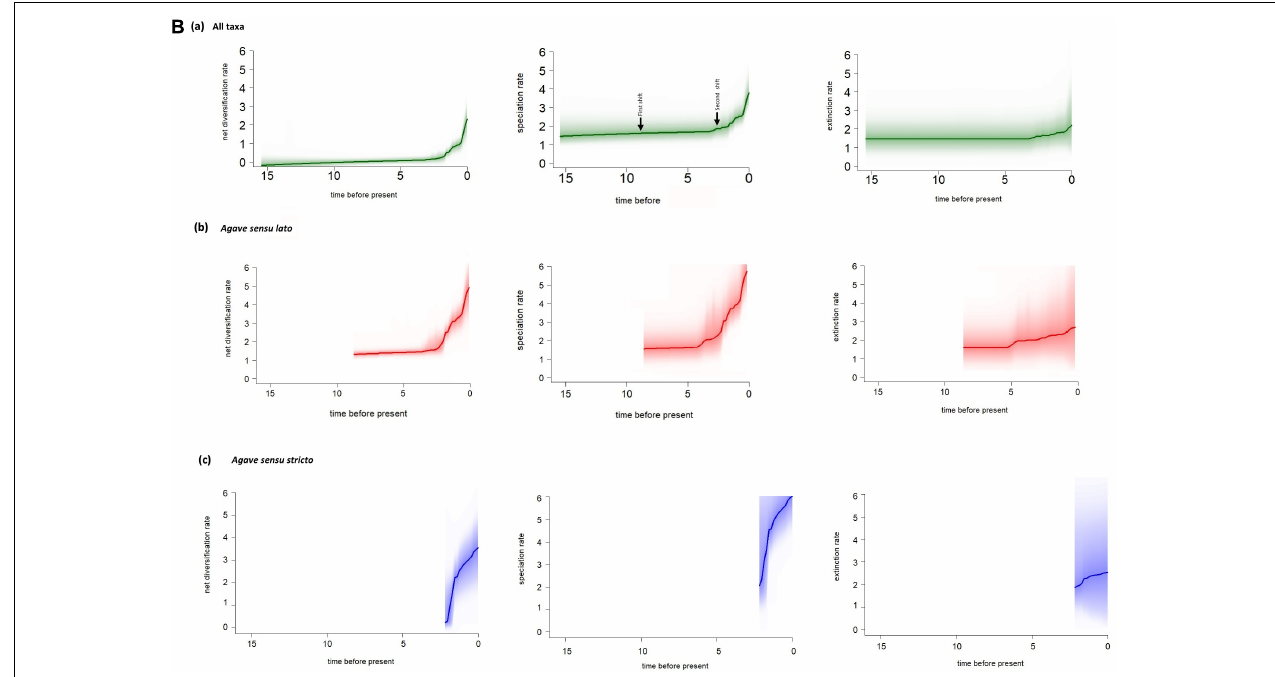
FIGURE 4 | BAMM analysis of rate shift configurations and diversification within Agave sensu lato . (A) Rate shift configurations with the two highest posterior probabilities from the 95% credible set are indicated with red circles, and branches are colored according to median net diversification rates (cool colors = slow, warm = fast). The first shift corresponds to the stem of A. bracteosa branch and the sister group Agave sensu lato clade, and the second shift corresponds to the Agave sensu stricto clade. Group III corresponds to the group including A. parryi , Group IV corresponds to the group including A. angustifolia , and Group V corresponds to the group including A. americana and A. datylio . (B) Evolutionary rates through time plots for (a) all taxa sampled, (b) Agave sensu lato , and (c) Agave sensu stricto ; solid lines denote the mean of each rate-through-time curve across all agaves, and the shading intensity of the colored line for each species reflects the relative probability of a given diversification trajectory, with upper and lower bounds representing the 90% Bayesian credible interval on the distribution of rates through time.